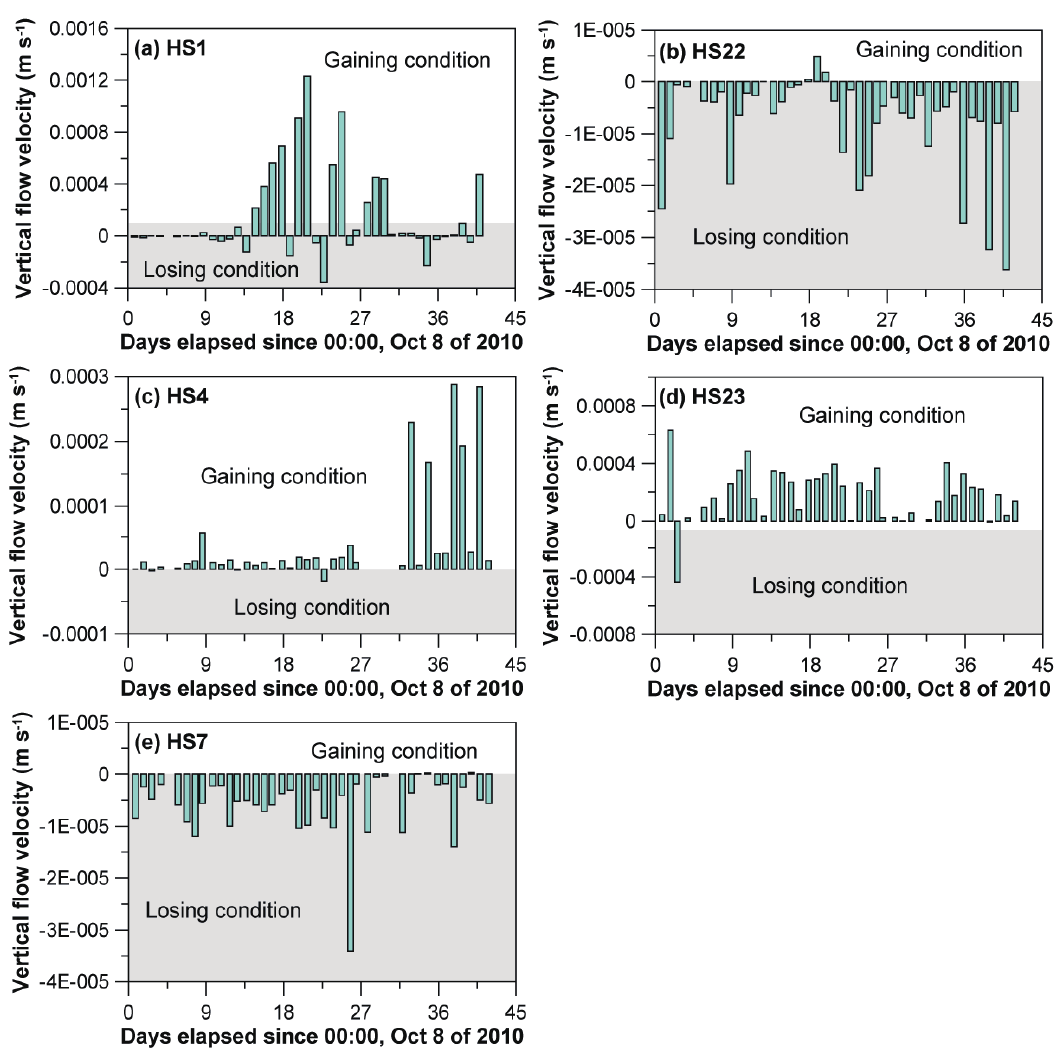
Figure 9. Vertical flow velocities calculated for the streambed (depth = 10 cm) using